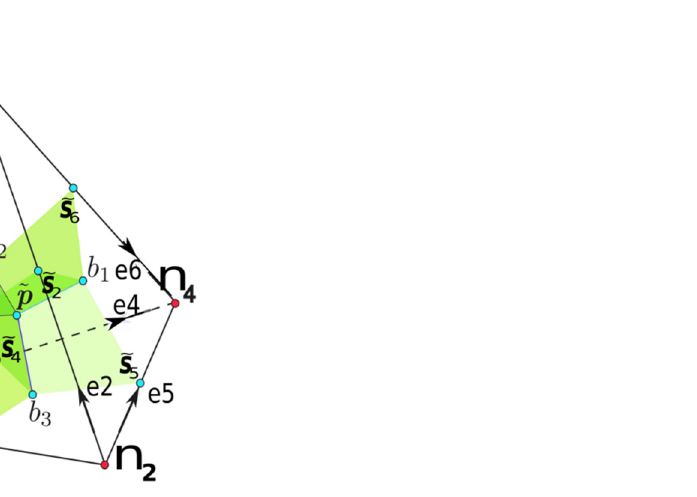
Figure 1. Reference tetrahedron for equations programming. The elements of the primal mesh are represented in black and dual planes in green. A current associated with the dual plane 𝑆(cid:4634) (cid:2871) is also shown.